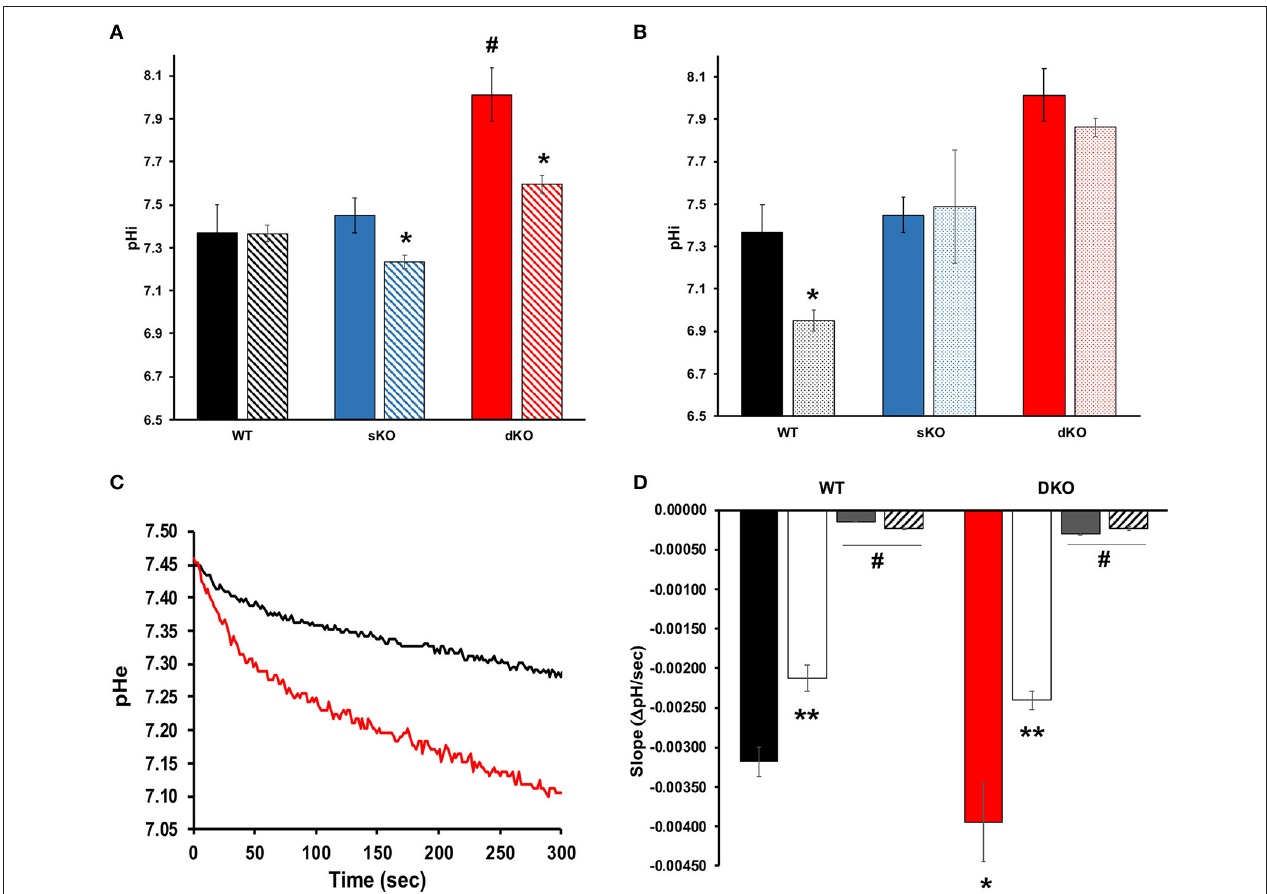
FIGURE 6 | Intracellular pH and proton extrusion. (A) Intracellular pH measurements of epimastigotes in standard (solid bars) or NMDG buffer (striped bars). Values represent Mean ± SD of 4 independent experiments. # indicates p < 0.05 compared with WT, * p < 0.05 compared with the values obtained in standard buffer. (B) Effect of BaCl 2 on pH regulation. Values of intracellular pH were compared in standard buffer with (dotted bars) or without (solid bars) 1mM BaCl 2 . * p < 0.05 from 4 independent experiments. (C) Representative traces showing proton extrusion in epimastigotes WT (black trace) or TcCAKC dKO (red trace) measured with BCECF free acid. (D) Slope analysis for the first 50s of proton extrusion under standard low buffering solution conditions (WT: black bar, dKO: red bar), K + -free (white bars), Na + free (gray bars) or NMDG buffer (striped bars). Values are Mean ± SD of 4 independent experiments. * p < 0.05 compared with WT in standard buffer, ** p < 0.05 for each strain in K + free compared with the values obtained in standard buffer, # p < 0.05 of Na + free or NMDG buffer compared with standard conditions.